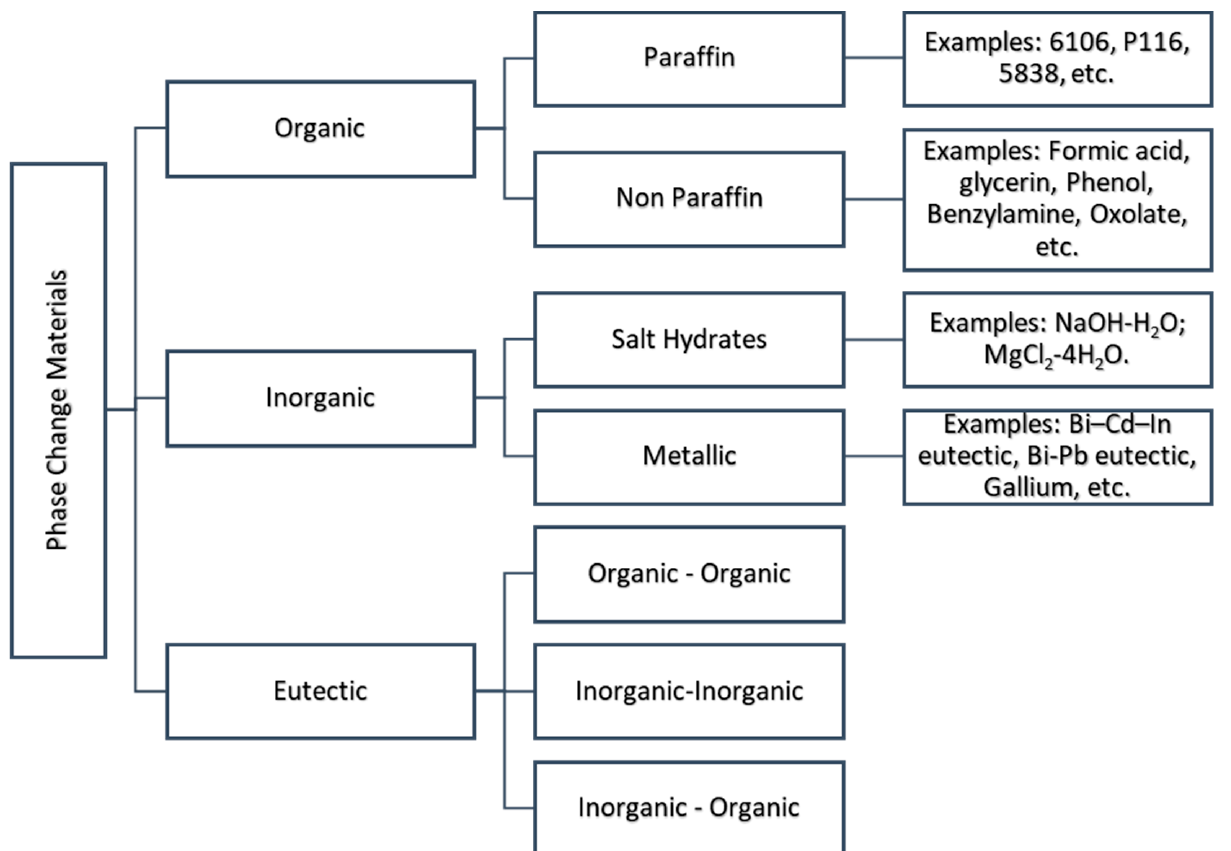
Figure 1. Phase change material (PCM) classification with several examples.